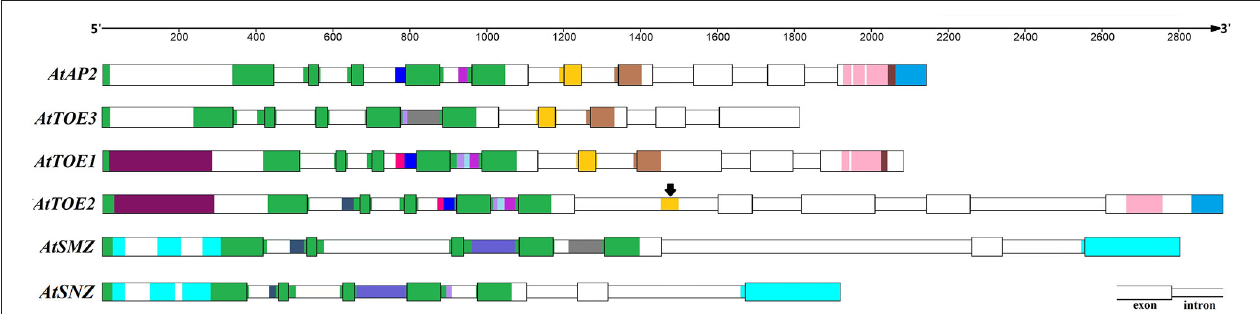
FIGURE 6 | Alignment of Genomic Sequences of AP2 Group Genes in A. thaliana . The sequence regions with same color in this figure have higher homology with each other. Black arrows means one intron region (gold) in AtTOE2 has higher sequence similarity with the sixth exon in AtAP2 , AtTOE3, and AtTOE1 .